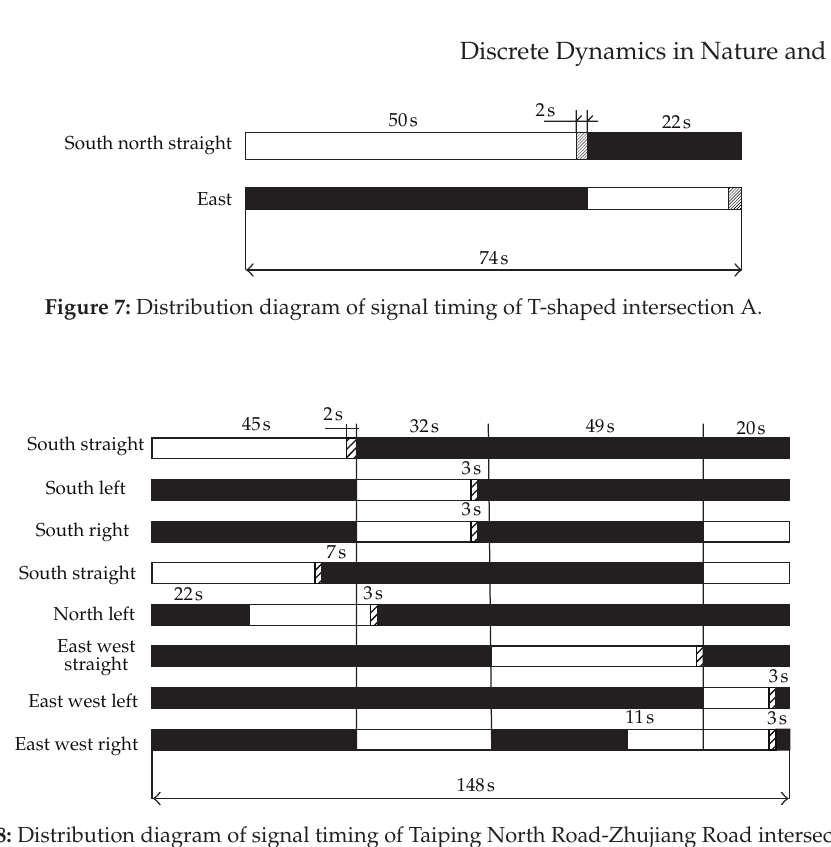
Figure 8: Distribution diagram of signal timing of Taiping North Road-Zhujiang Road